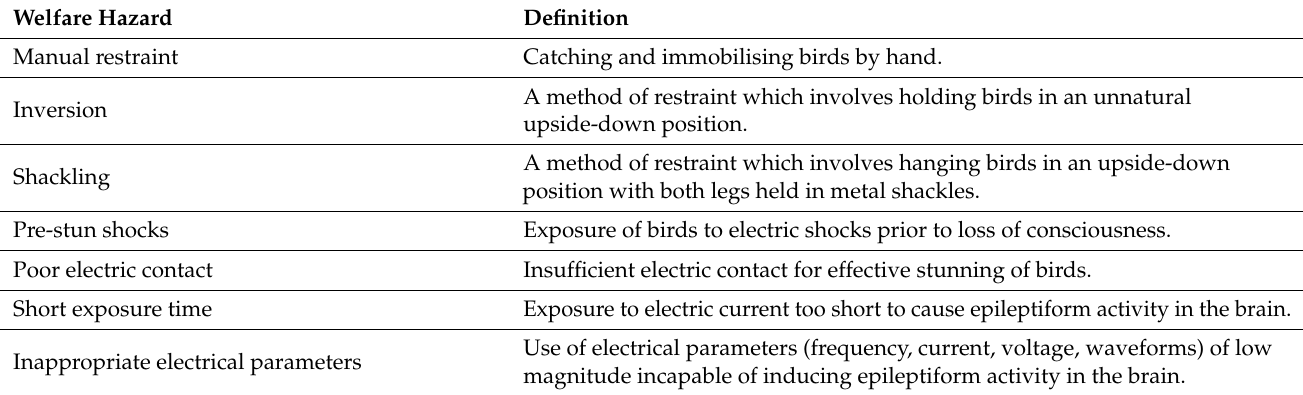
Table 2. Animal welfare hazards associated with water bath stunning, and their definitions (defini- tions adapted from